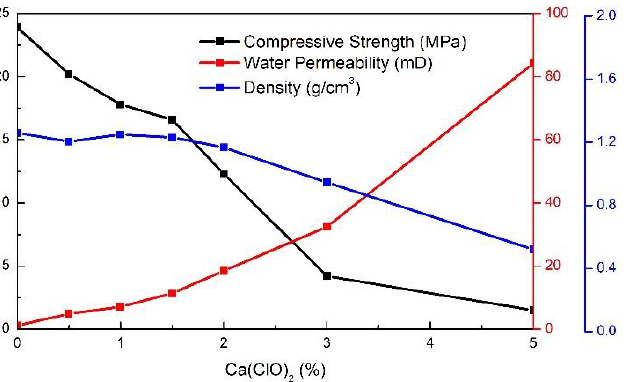
Figure 4. Effect of different mass concentrations of calcium hypochlorite + urea gas-generating sys- tem on the performance of cement stone system on the performance of cement